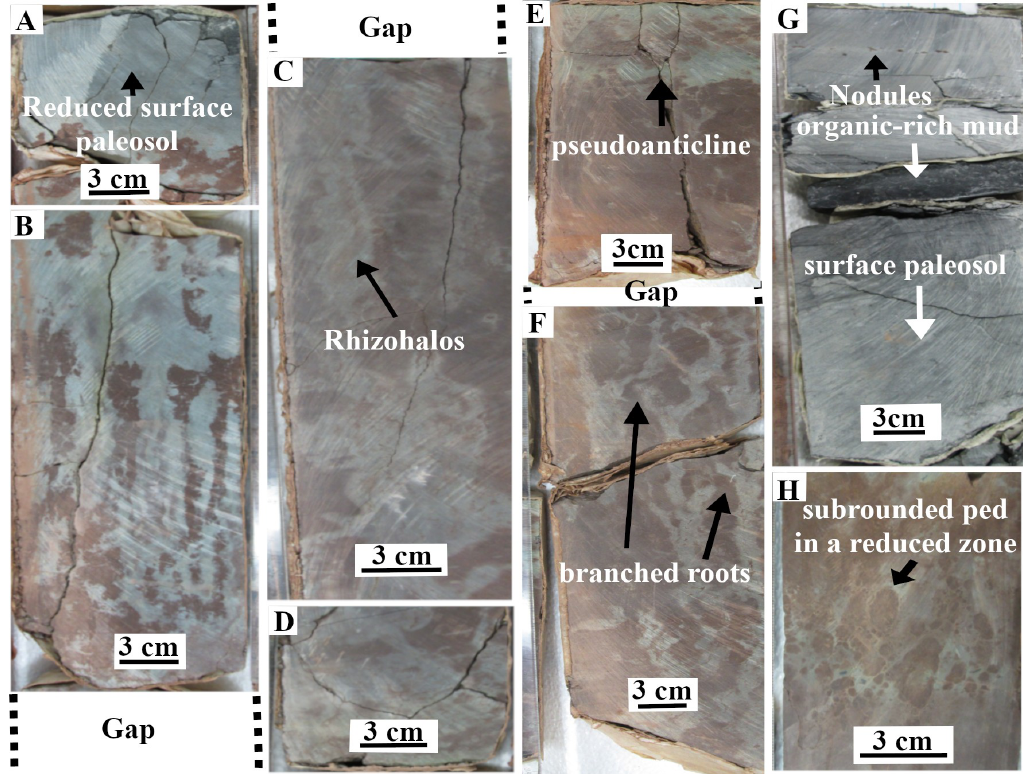
Fig 6. Drill-core extracts from the TCHD. The core-extracts were selected that possessed the representative features of the subsoil (Fig 6A–6F and 6H) from the well-drained areas as well as hydromorphic paleosol (Fig 6G). (A) Note the reduced surface paleosol in comparison to the more oxic subsoil. (B) Reduced areas are dominant around rhizohalos. The almost vertical rhizohalos indicated that roots didn’t face resistance in the deep soil. (C) Note the branching root-casts (marked by arrow) surrounded by the rhizohalos. (D) The figure shows the end of top-paleosol and the beginning of underlying paleosol. The underlying paleosol has a reduction-zone followed by a desiccation zone (E). (F) The figure shows the rooting zone of the underlying paleosol where the branched root system is observable. (G) A core extract from hydromorphic paleosol: Note the iron-manganese zone, organic-rich zone, and underlying surface hydromorphic paleosol recorded variations in moisture- saturation of the paleosol. (H) A desiccation zone from the well-drained paleo-vertisol: The orientation of the subrounded peds in the reduced matrix, and likewise, the subrounded organic materials are